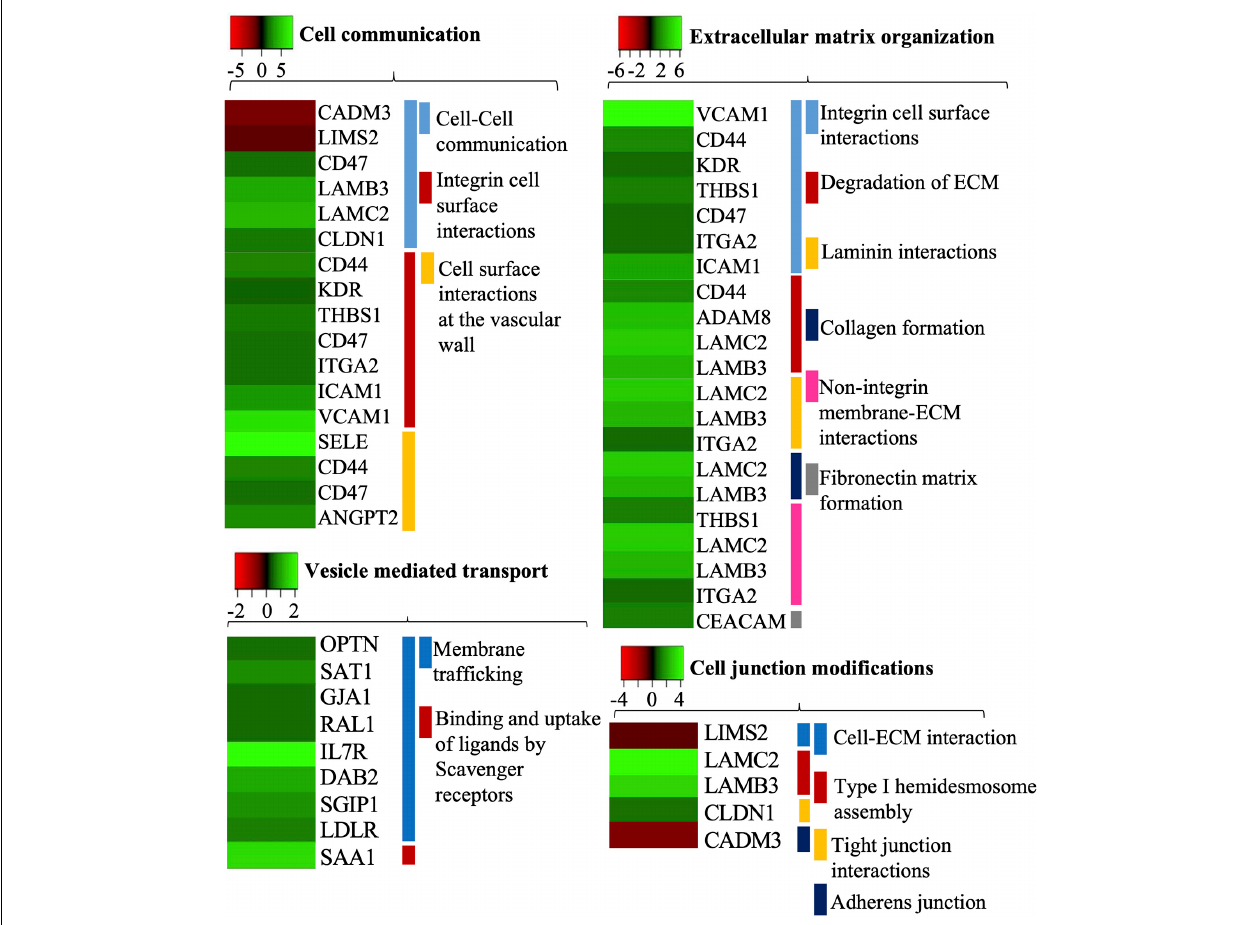
FIGURE 2 | Gene ontology biological processes (cell communication, cell junction modifications, extracellular matrix organization, and vesicle-mediated transport) activated by B. bavariensis in hBMECs. Green shaded genes—upregulated, red shaded genes—downregulated. The intensity of the color indicates the degree of expression level. The range of the fold change (logFC) is presented in the